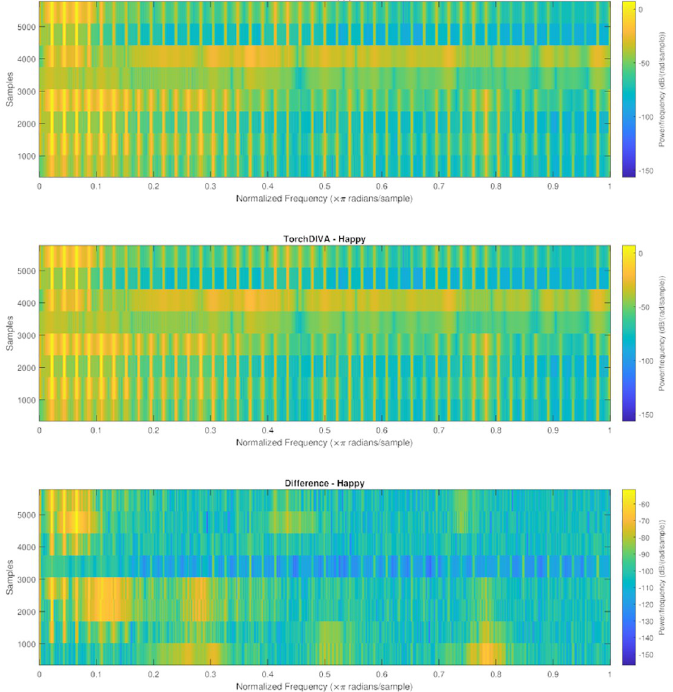
Fig 5. DIVA and TorchDIVA spectrogram comparison. Speech production ‘happy’ output audio comparison. The first subplot is DIVA, the second is TorchDIVA, and the bottom is the difference calculated from the two output